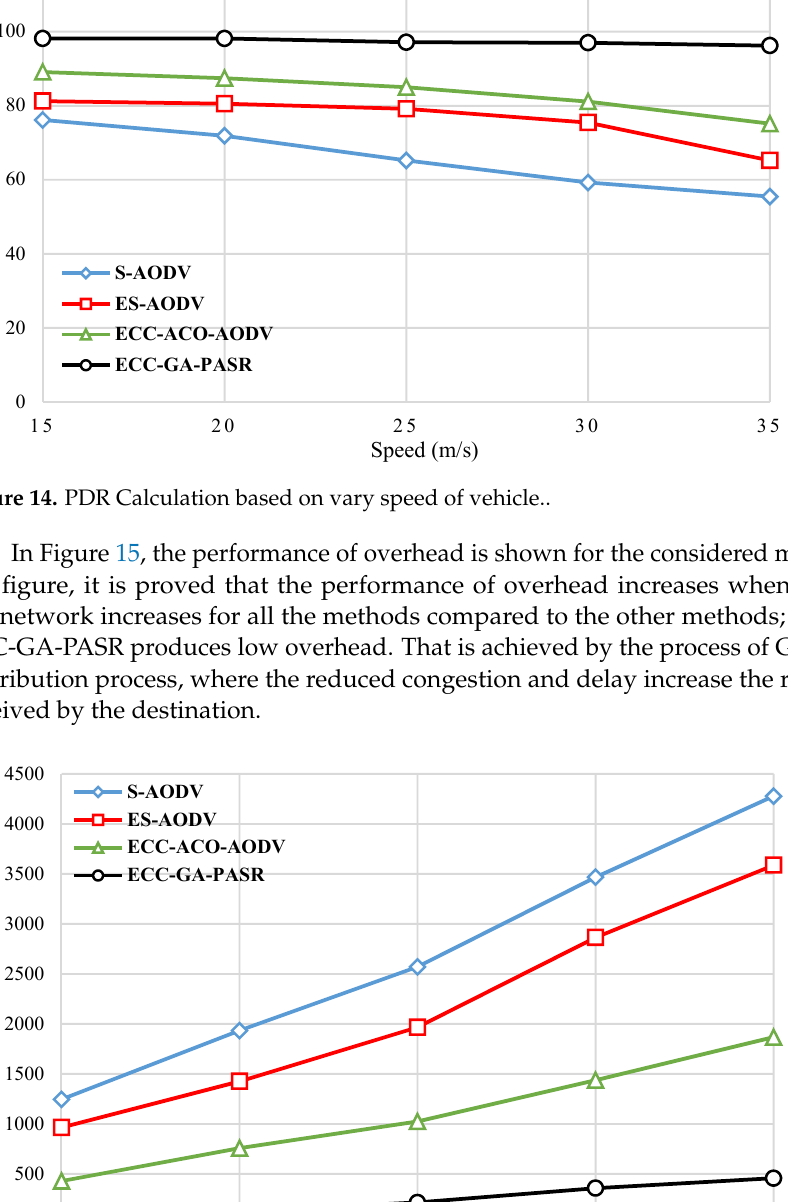
Figure 16. Packet Loss Calculation based on vary speed of vehicle.